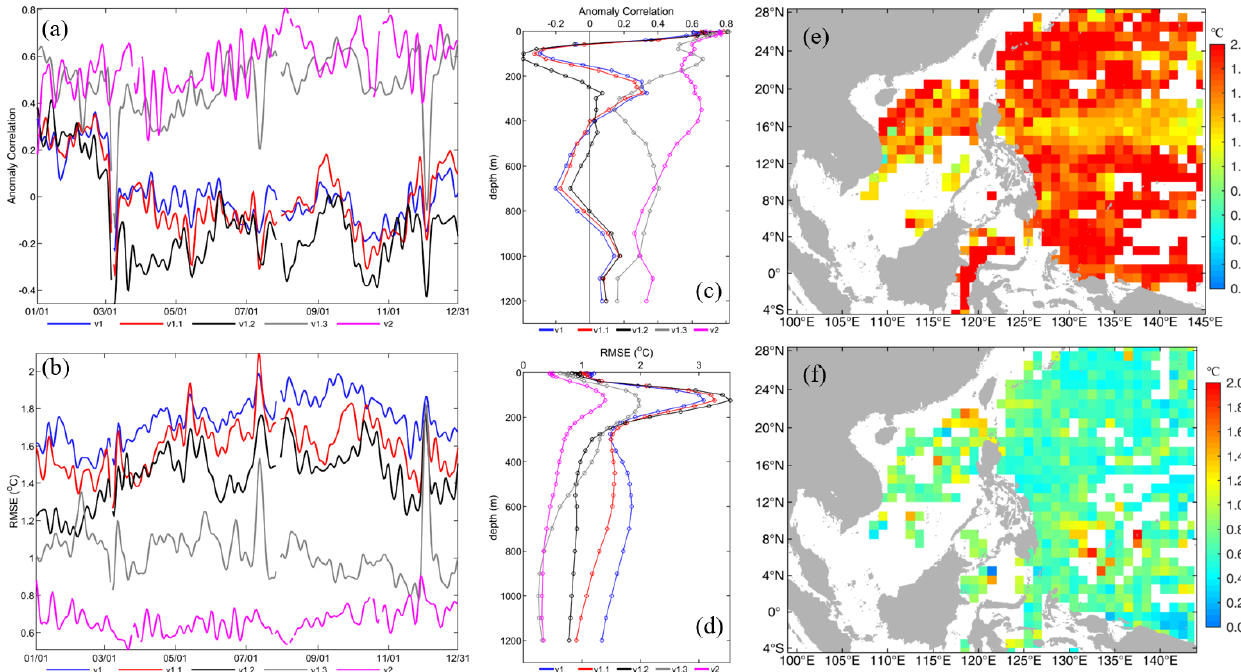
Figure 13. Panels (a) and (b) are similar to Fig. 10a and b but for the temperature profile. Panels (c) and (d) are vertical distributions of best estimates for each sub-version against observations as a function of depth, v1, v1.1, v1.2, and v1.3 without data assimilation in 2013 and v2 with data assimilation in 2018. Panels (e) and (f) are similar to Fig. 10c and d but for the temperature profile in v1 and v2, respectively.